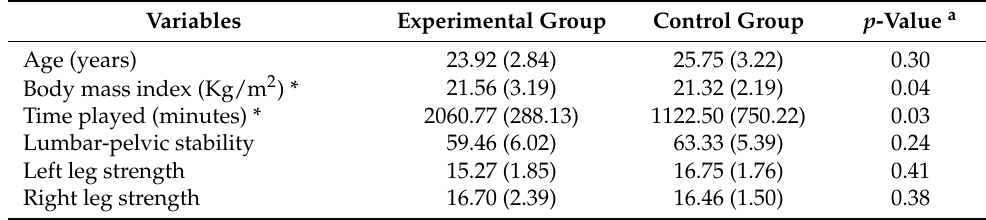
Table 1. Baseline characteristics (median and interquartile range) for the sample and depending on the study group.